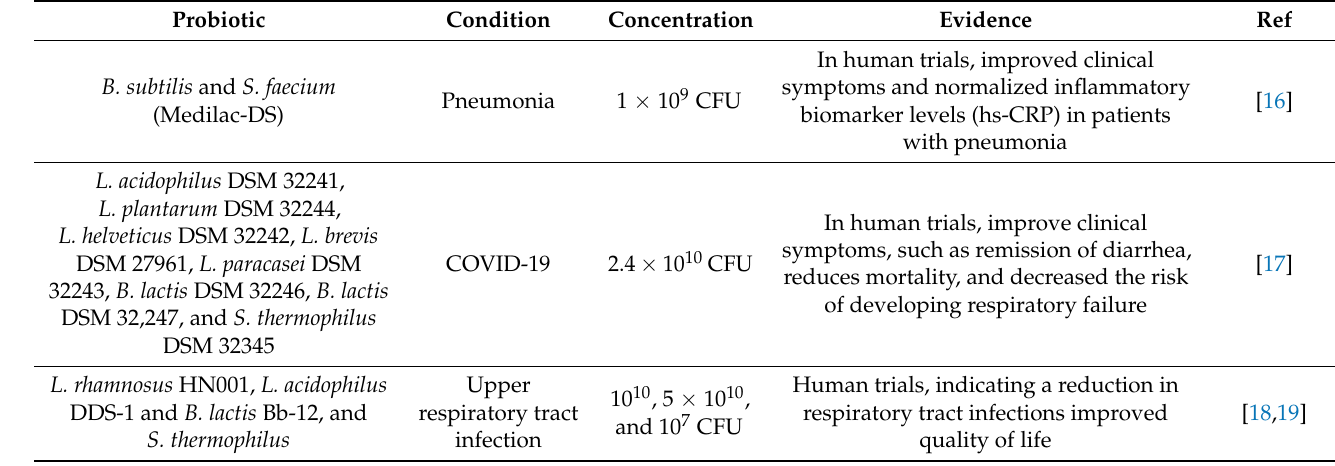
Table 1. Probiotics associated with treatment of viral